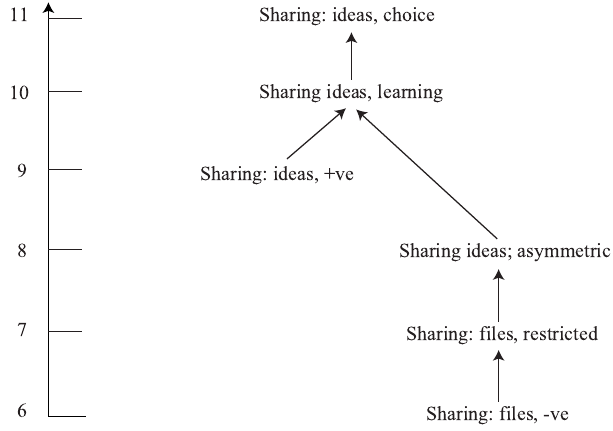
Figure 1. Hierarchical structure to